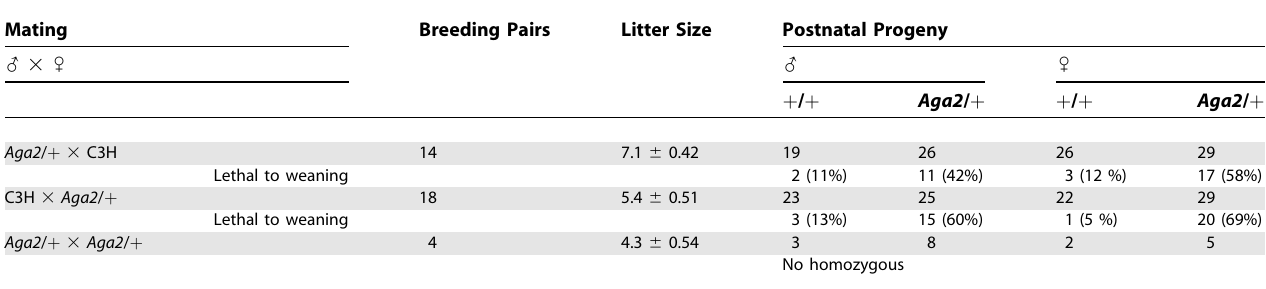
Table 1. Mode of Inheritance and Postnatal Lethality Mating Breeding Pairs Litter Size Postnatal